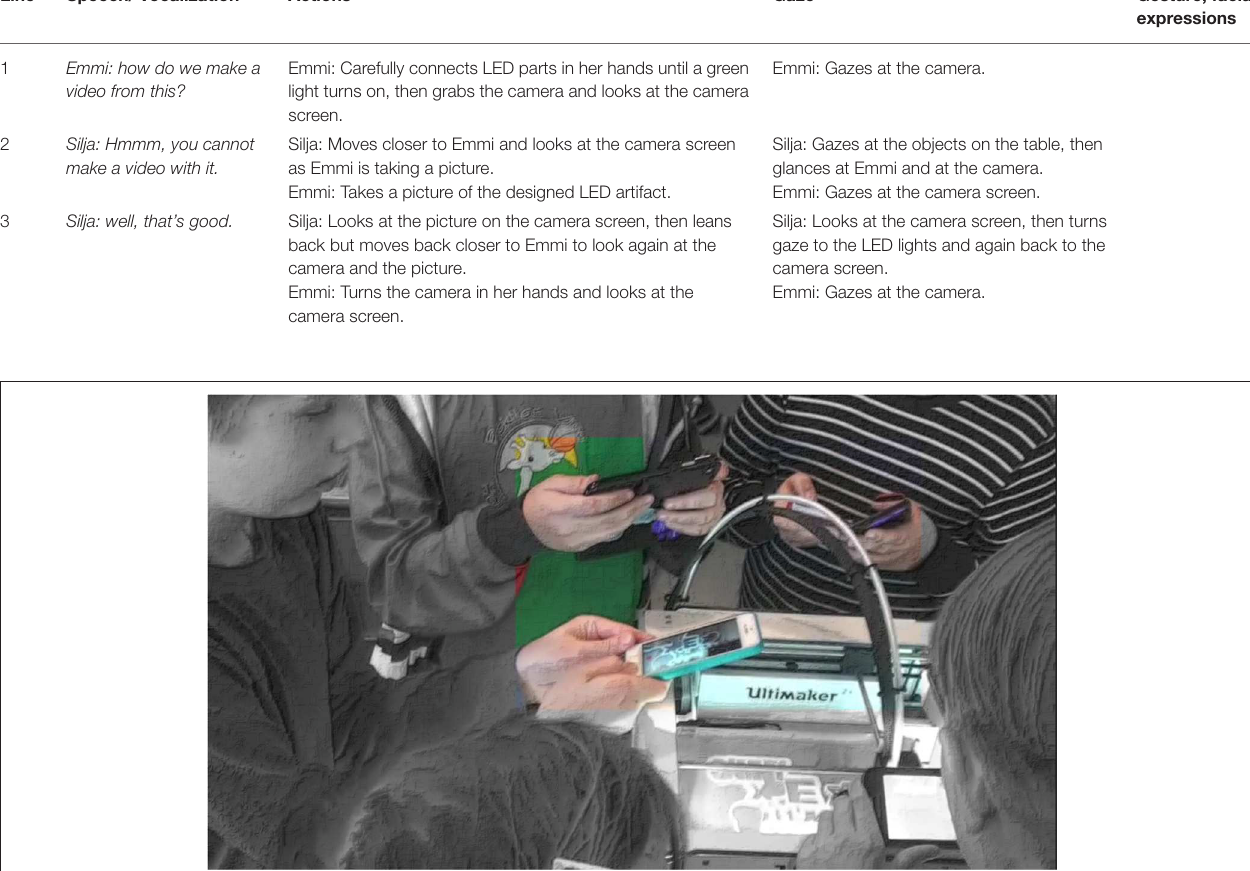
FIGURE 3 | Students working on the keychain customizer design